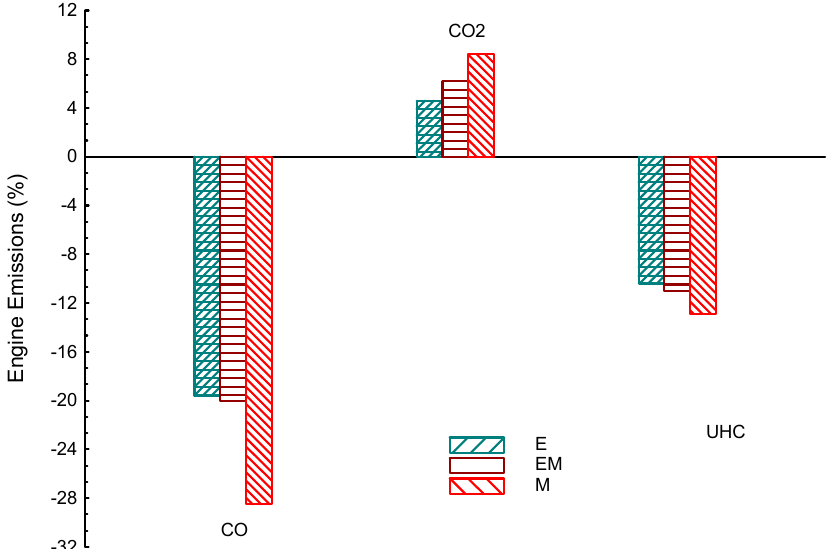
Figure 8. Comparisons of CO, CO 2 and UHC emissions for ethanol–methanol (EM), ethanol (E) and methanol (M) blended with gasoline and neat gasoline (baseline) in %.